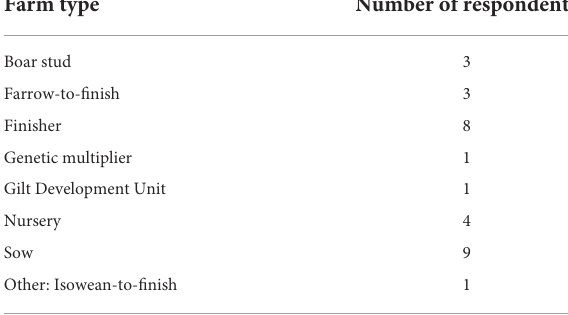
TABLE 1 Characteristics of survey